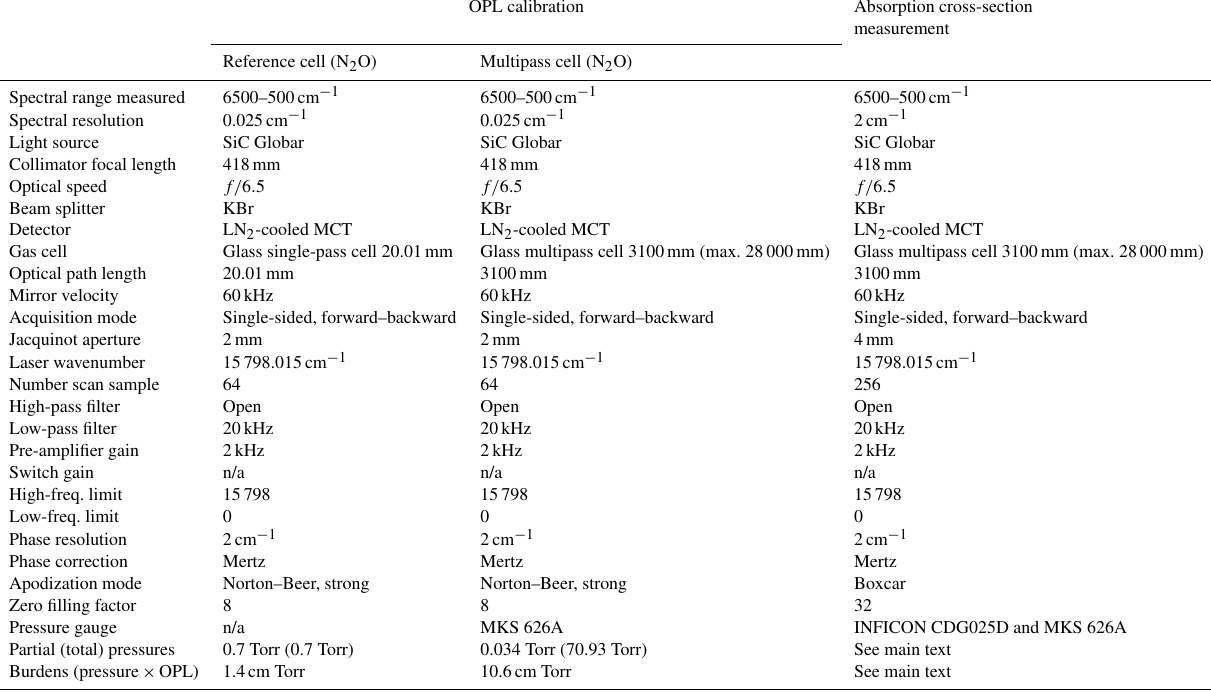
Table 1. Instrumental setup and experimental